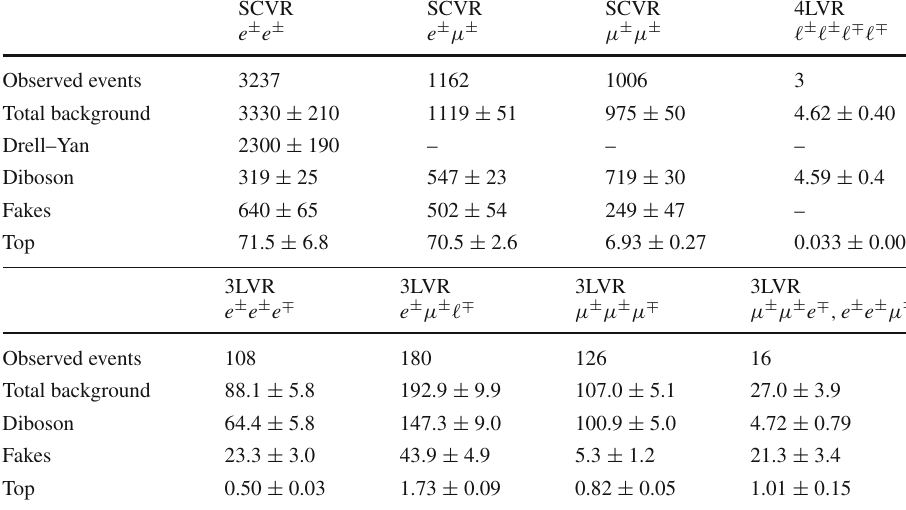
predicted background events in two-lepton and four-lepton validation regions (top) and three-lepton validation regions (bottom) after the fit, compared to the data. Uncertainties correspond to the total uncertainties in the predicted event yields, and are smaller for the total than the sum of the components in quadrature due to correlations between these components. Due to rounding the totals can differ from the sums of components. Background processes with a negligible yield are marked with the en dash